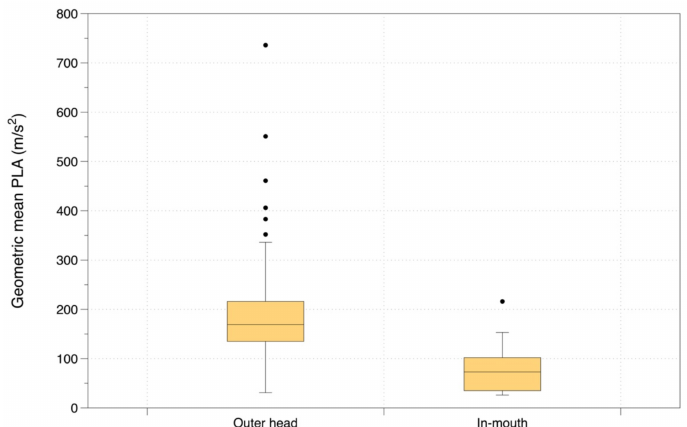
Figure 3. Geometric mean PLA by method of data collection for observational studies.